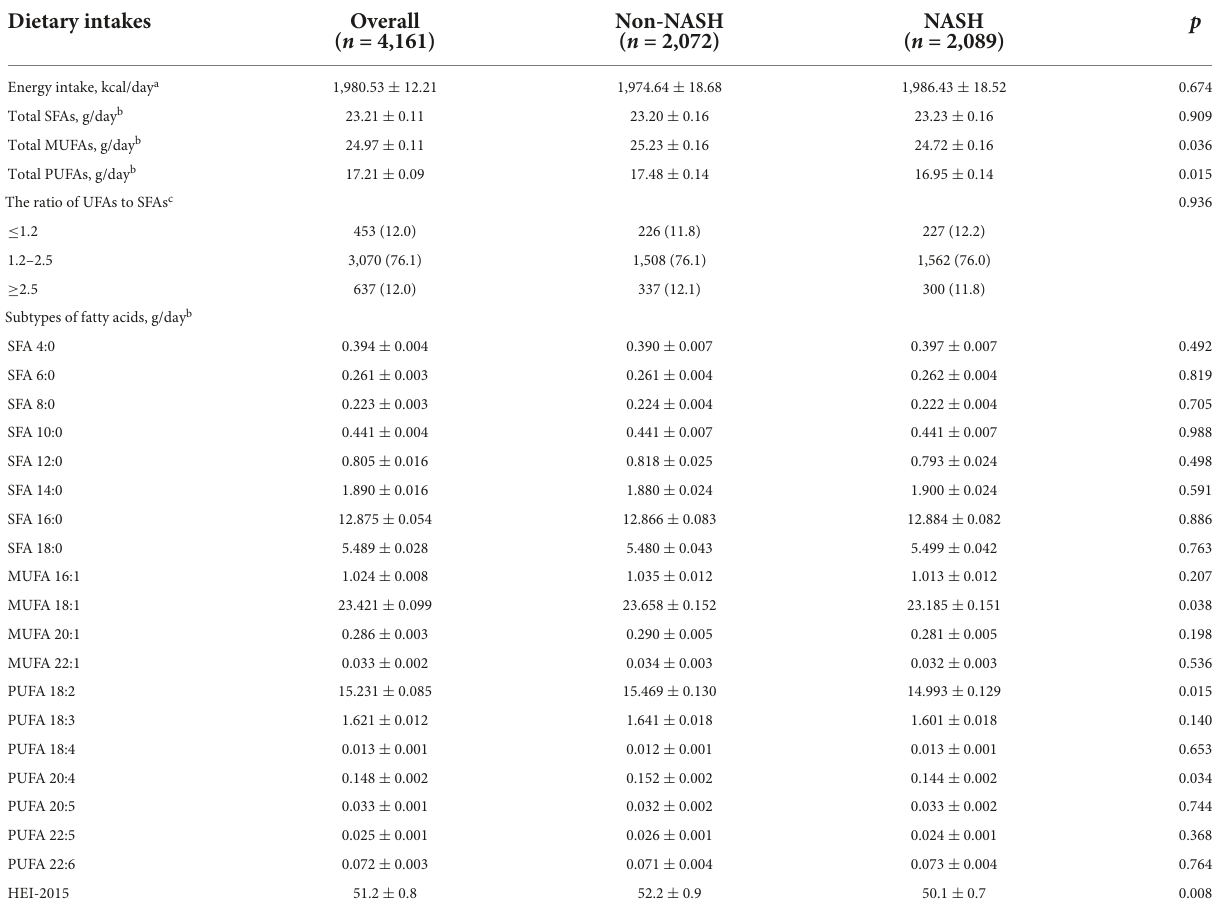
TABLE 2 Dietary fatty acids intakes of participants of this study. Dietary intakes Overall ( n = 4,161)